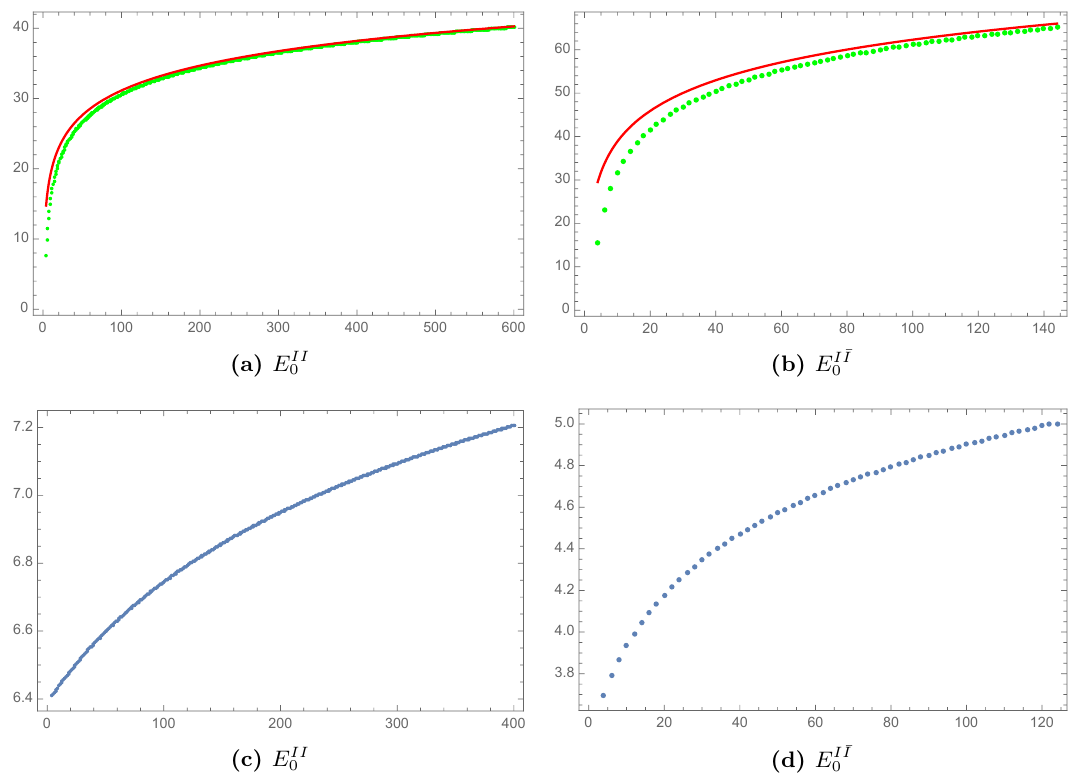
Figure 3. We plot in upper panels numerical results of 2-instanton corrections (left: E II E I (cid:22) I ) as a function of Q = 2 (cid:25)=(cid:30) in green dots versus theoretical predictions (4.28), (4.30) in red 0 lines. Plotted in lower panels are the matching digits between the numerical and theoretical results; we perform Richardson transformations of order 200 for E II improve